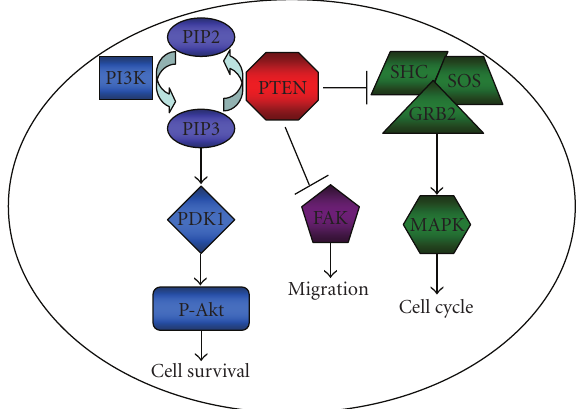
Figure 1: PTEN protein signaling pathways. PTEN’s lipid phos- phatase activity dephosphorylates PIP3 to PIP2 inhibiting PDK1- mediated Akt phosphorylation and downregulating Akt-mediated cell survival. PTEN’s protein phosphatase activity inhibits the phosphorylation of FAK to prevent cell migration. PTEN’s protein phosphatase activity also dephosphorylates the SHC/SOS/GRB2 complex resulting in the decreased phosphorylation of MAPK and inhibition of the cell